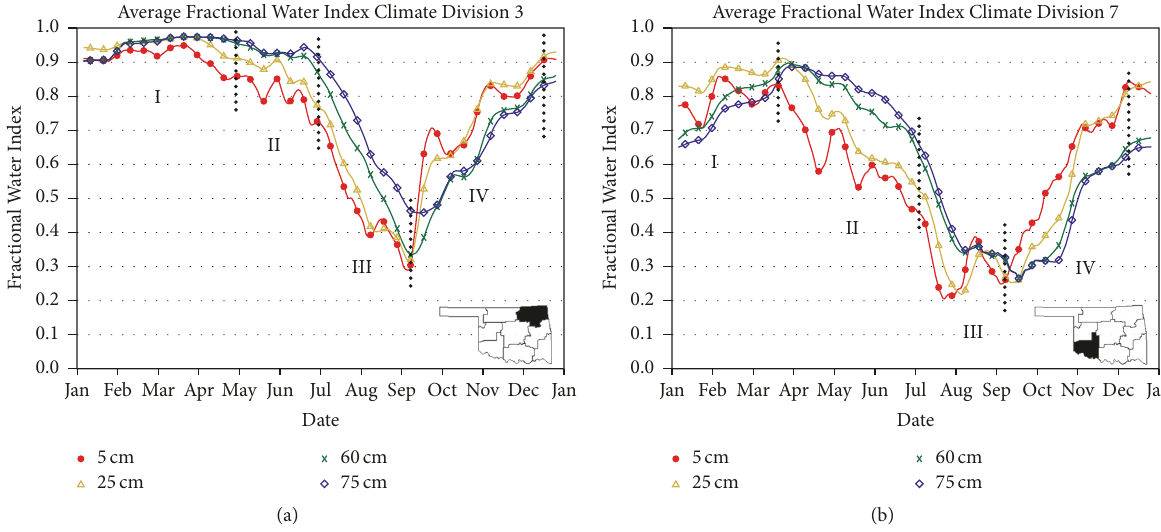
Figure 5: The average FWI trend for two different climate divisions in Oklahoma. The right plot is for the Southwest Climate division and the left plot is for the Northeast Climate Division (shown in the bottom right corner of each plot). The roman numerals on the plot represent the moist plateau phase (I: November to mid-March), the transitional drying phase (II: mid-March to mid-June), enhanced drying phase